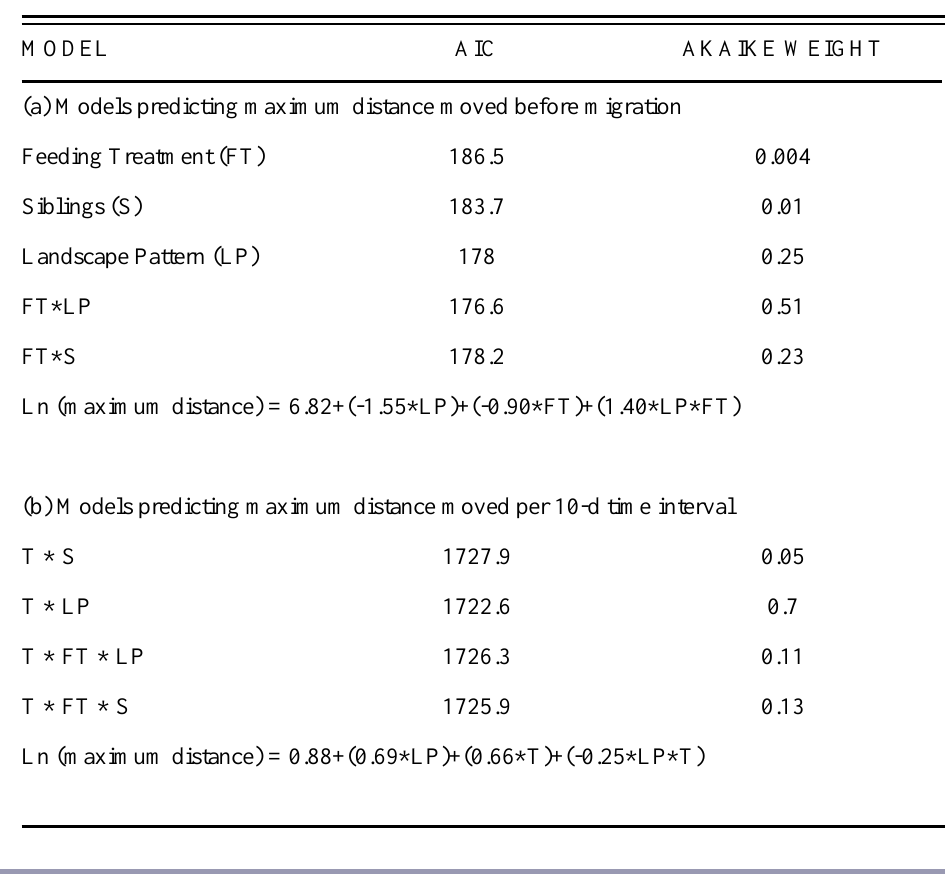
Table 1. Akaike’s Information Criterion for five models in candidate set. Results are shown for (a) maximum distance moved over the duration of the study, and (b) the maximum distance moved per 10-d interval before migration. Akaike weights are scaled between 0 and 1, with higher weights indicating greater support. Parameter estimates are also reported for the model selected as having the best fit. The response variable of distance moved was ln-transformed before analysis. A constant of 1 was added to the distance moved per unit time before transformation because of the presence of zeros. Landscape pattern was a dummy variable coded 0 for large, 1 for small. Feeding treatment was a dummy variable coded 0 for fed, 1 for unfed. Time was a continuous variable ranging from 1 to 11, with each increment representing a 10-d interval relative to hatching date. MODEL AIC AKAIKE WEIGHT